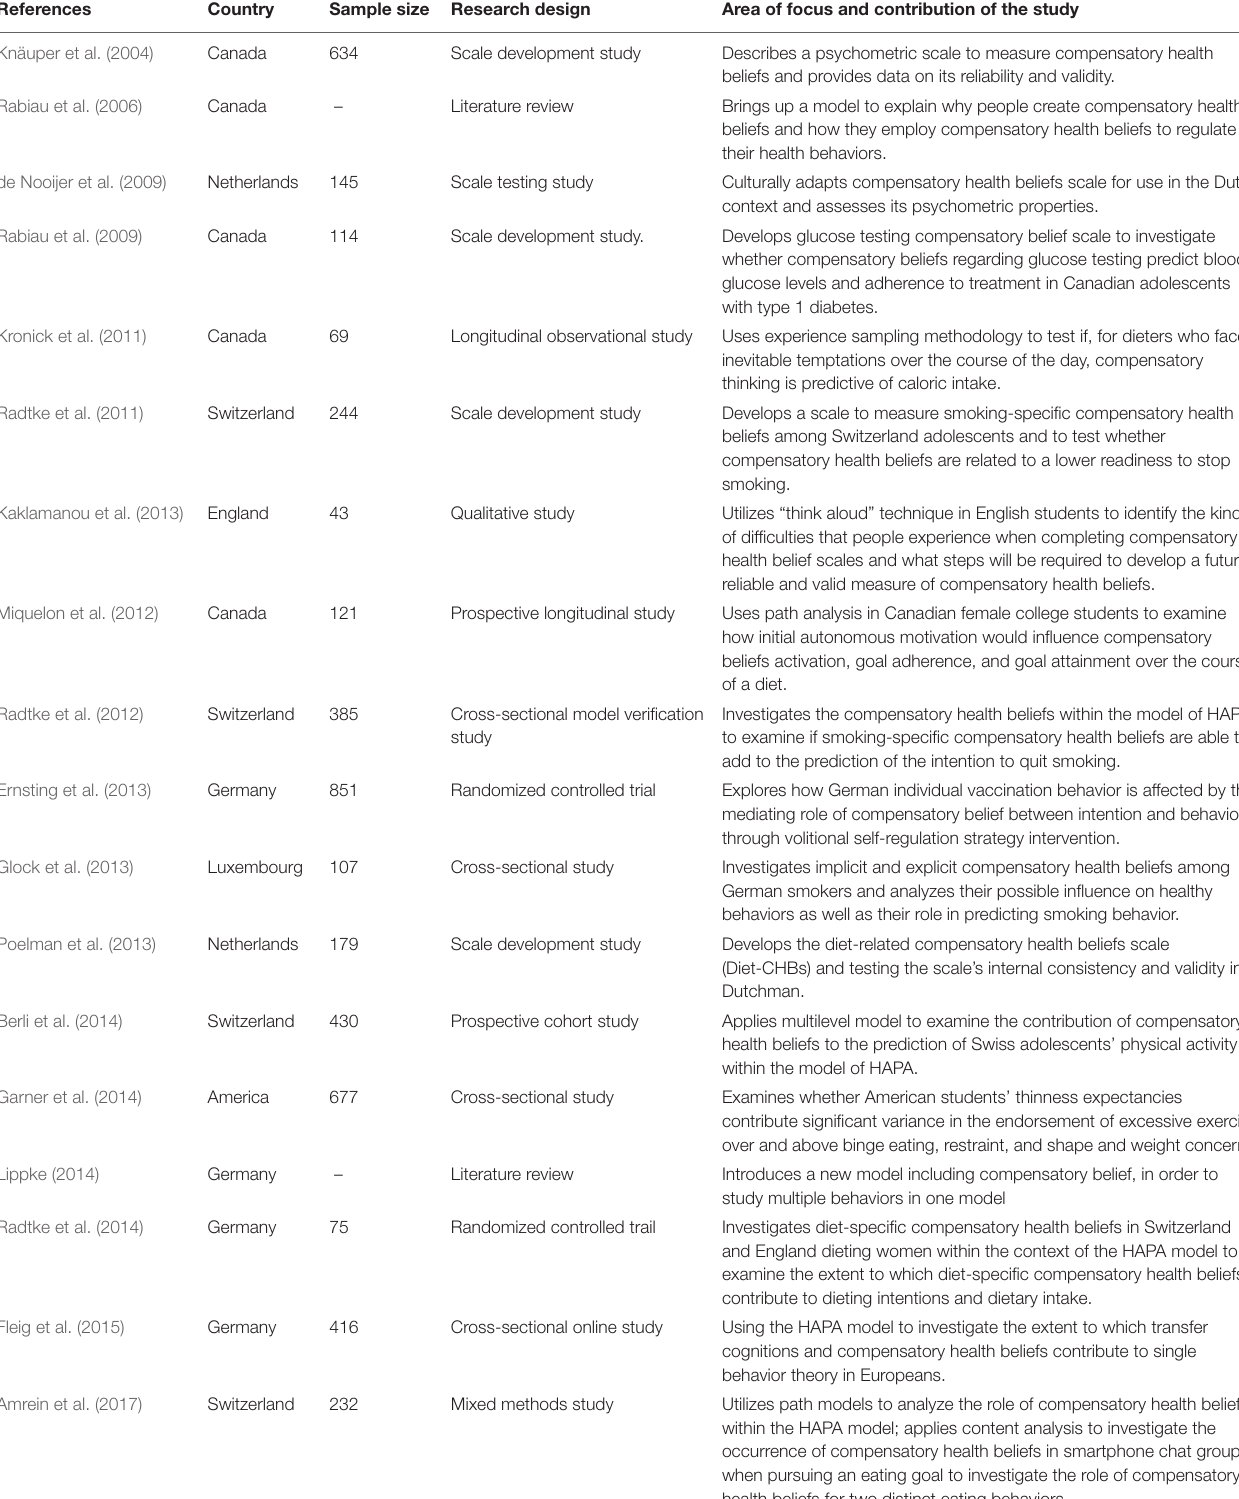
TABLE 2 | Articles selected for the final